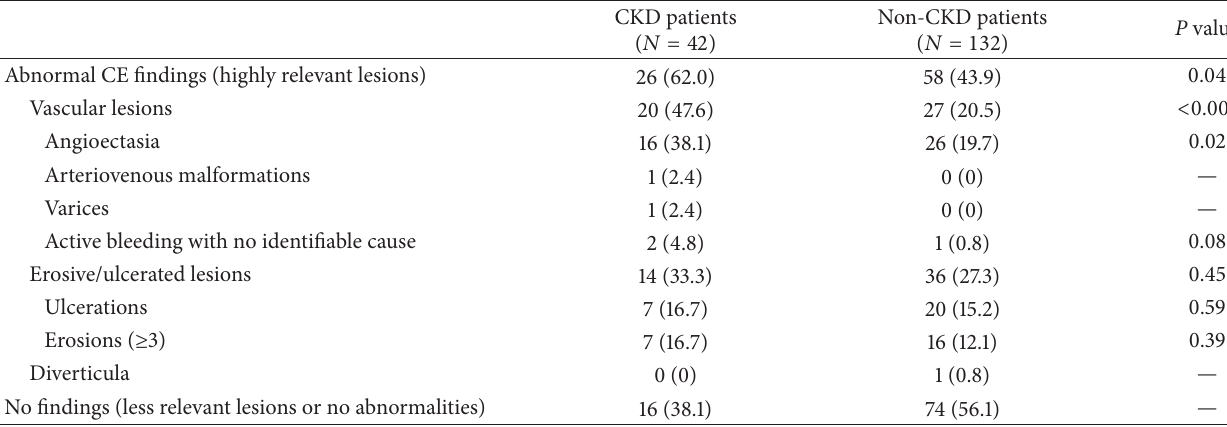
Table 2: Comparison of the CE findings between the CKD and non-CKD patients.